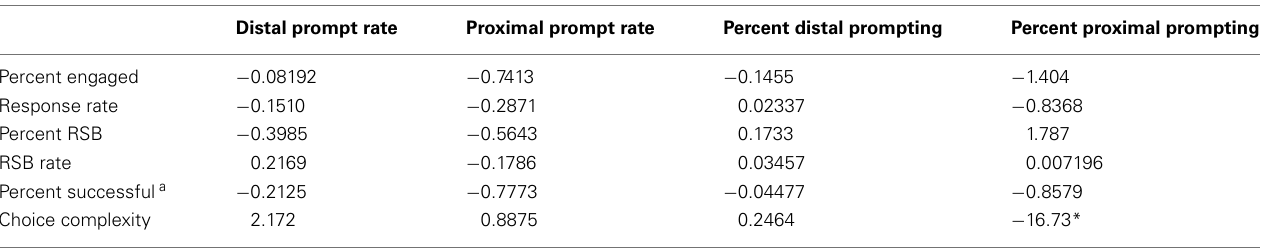
Table 8 | Effects of